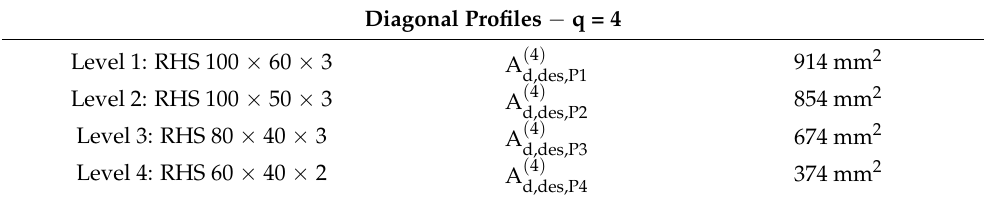
Table 10. Diagonal cross-sections of the multi-storey case study with structure factor equal to 4.